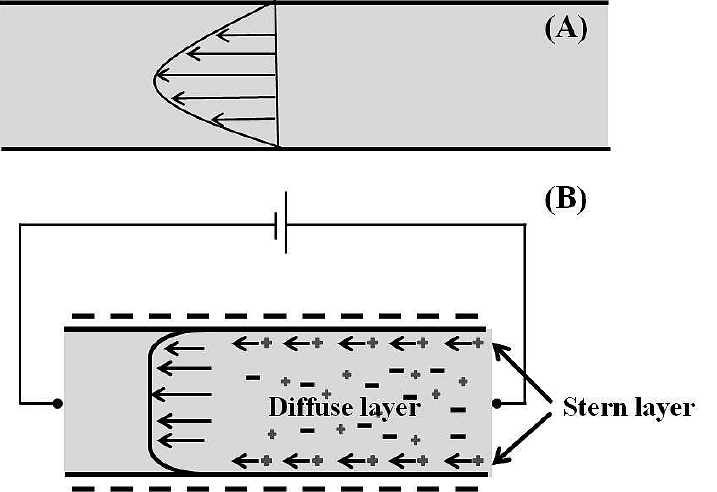
Figure 1. The fluid flow profile within the microfluidic channels. ( A ) Pseudo-parabolic profile in pressure-driven flow; ( B ) Uniform velocity profile in electro-osmotic driven